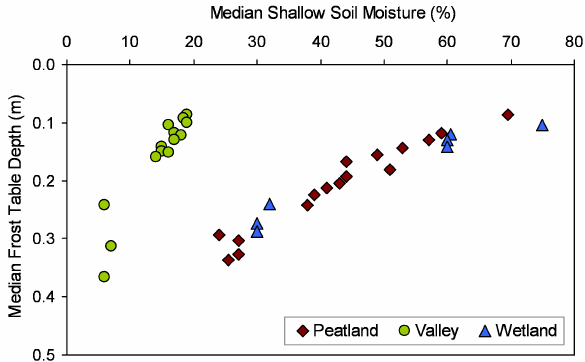
Fig. 9. The median shallow soil moisture (SM) and frost ta- ble depth (FT) from all survey dates showing the overall tem- poral patterns. The line of best fit equation through the peat- land data was FT= − 0.006(SM)+0.5, r 2 was 0.94; at the valley site, FT= − 0.02(SM)+0.4, r 2 was 0.89, and at the wetland site, FT= − 0.004(SM)+0.4, r 2 was 0.95. To focus on shallower thaw locations, frost table sample points with ≥ 1m depth were not in- cluded in the median